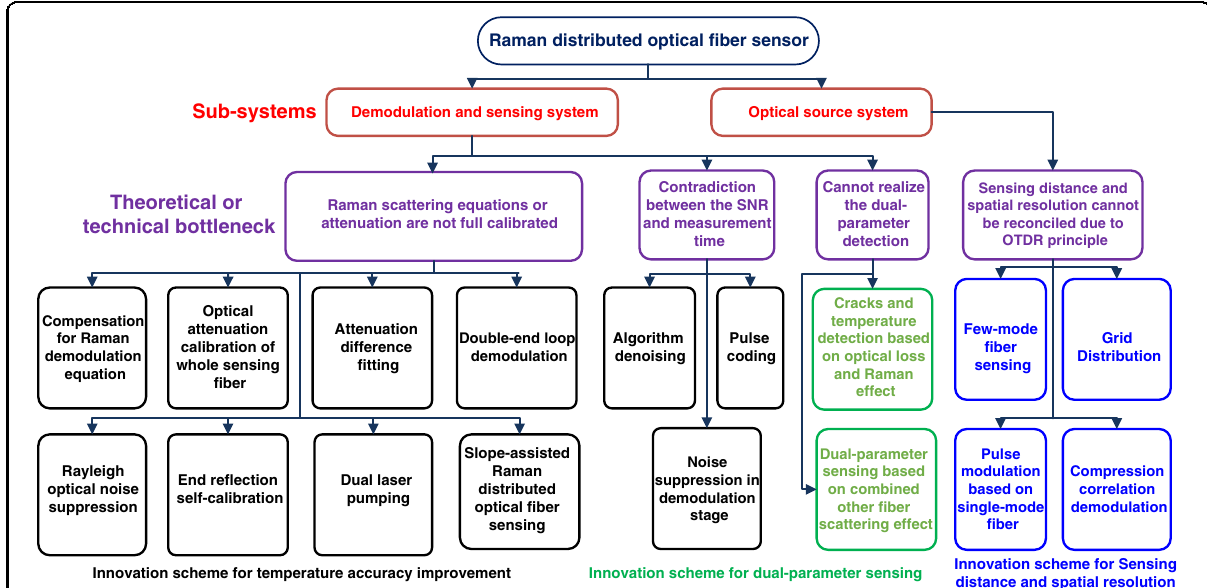
Fig. 2 Advanced schemes of the Raman distributed optical fi ber sensor. Among them, the red words represent the sub-systems. The black words represent the optimization scheme of temperature measurement accuracy, the blue words represent the optimization scheme of sensing distance and spatial resolution, the green words represent the dual-parameter sensing demodulation scheme, the purple words represent the theoretical or technical bottleneck of the